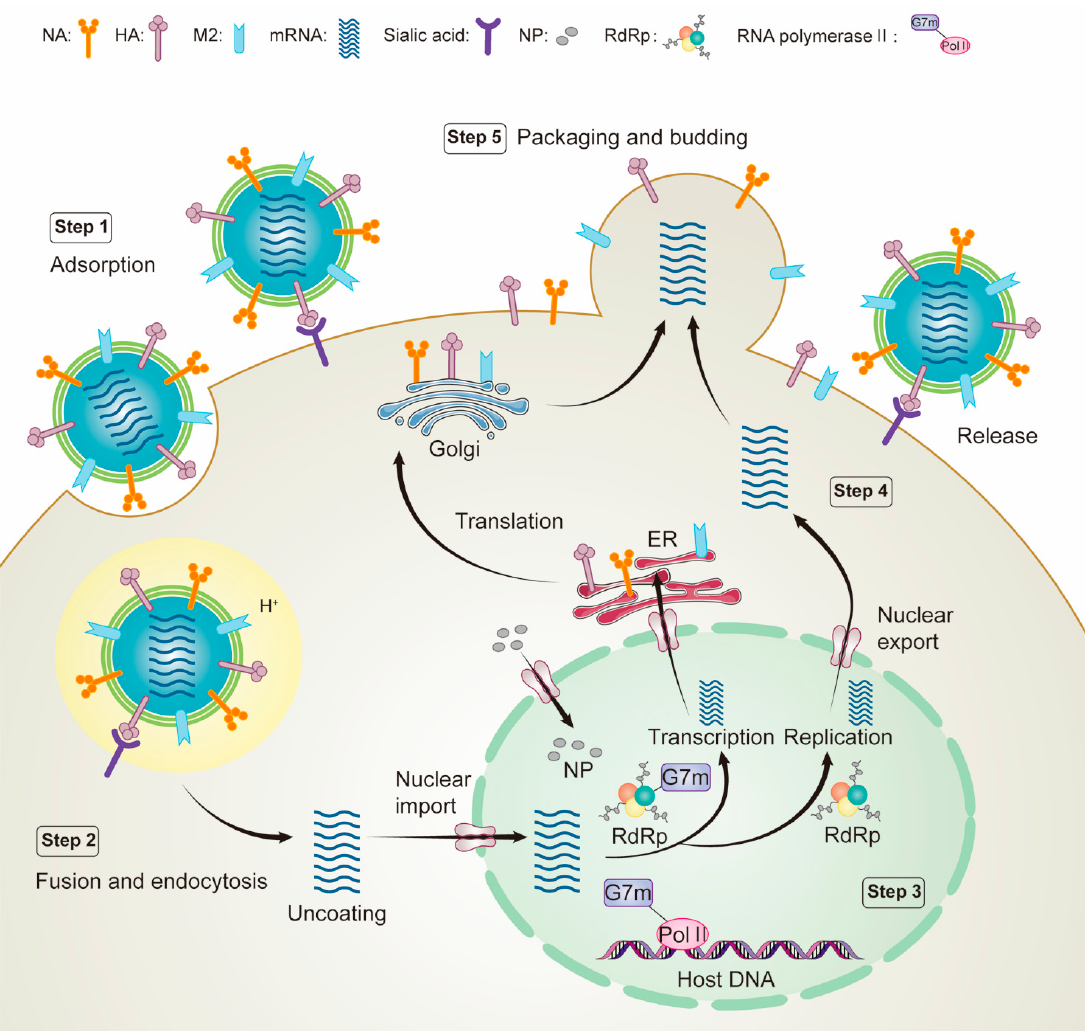
Figure 2. Schematic diagram of influenza virus life cycle: step 1, virus attaches to the host cell surface via the influenza virus surface glycoprotein hemagglutinin; step 2, influenza virus M2 protein produces ion channels that regulate the pH of the cell membrane, trigger fusion and release of viral ribonucleoprotein (vRNP) complexes into the cytoplasm; step 3, the vRNP complex is transported to the nucleus and RNA polymerase (PB2, PB1, and PA) begins transcription and replication of viral RNA; step 4, The newly synthesized viral surface proteins are transported to the cell surface via the Golgi apparatus, while the newly synthesized nuclear proteins are transported back to the nucleus for reassembly into the vRNP complex; and step 5, viral surface proteins are assembled into viral progeny. The viral progeny are finally budded and released from the cell membrane by NA, which cleaves sialic acid on the host cell membrane